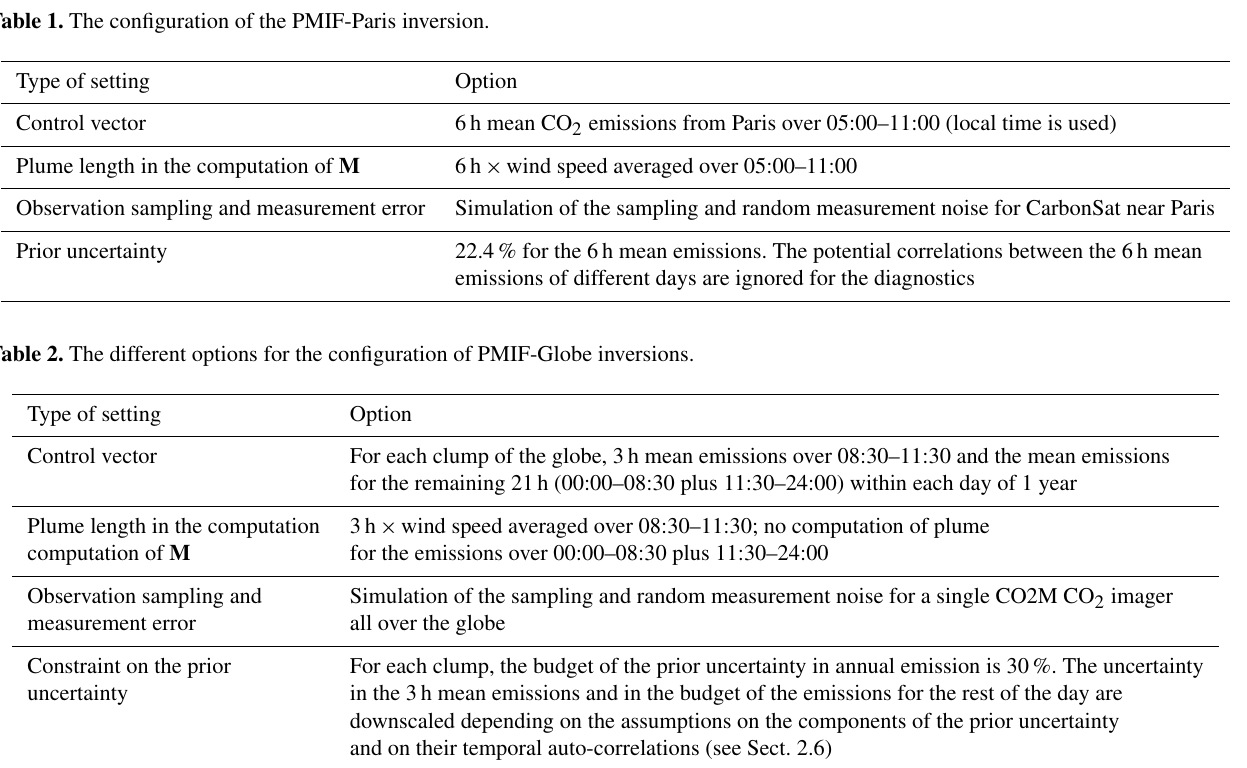
all over the globe Constraint on the prior For each clump, the budget of the prior uncertainty in annual emission is 30%. The uncertainty uncertainty in the 3h mean emissions and in the budget of the emissions for the rest of the day are downscaled depending on the assumptions on the components of the prior uncertainty and on their temporal auto-correlations (see Sect.